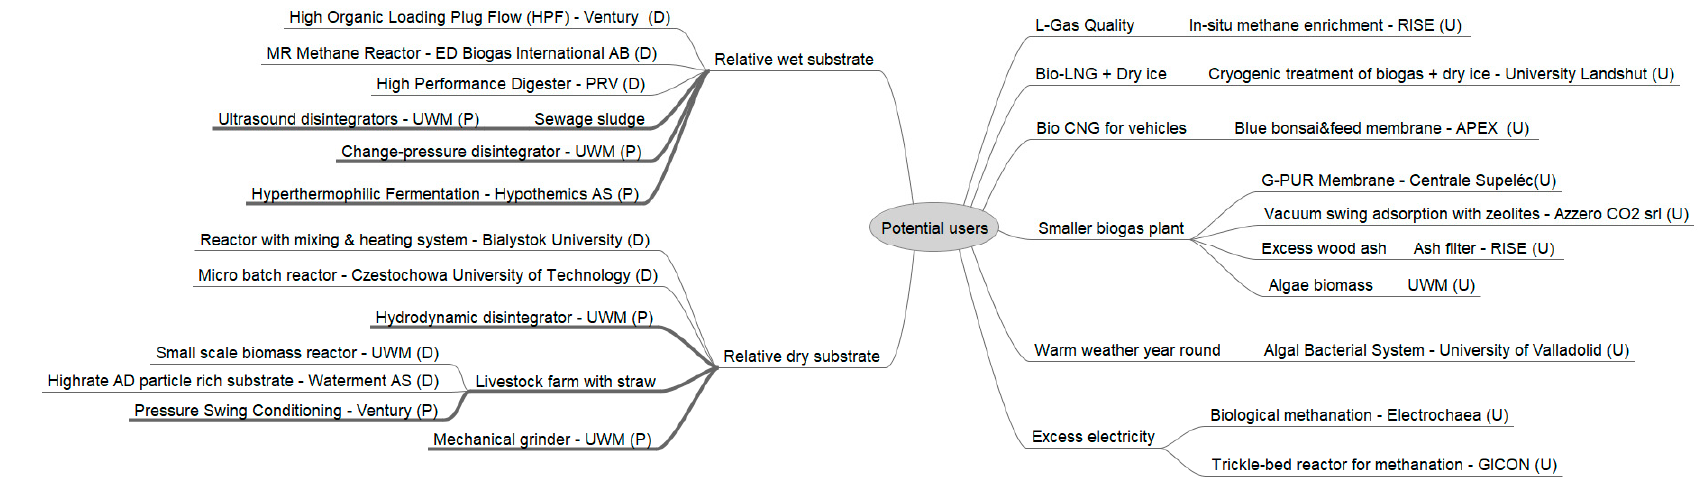
Figure A1. Graphical representation of the conditions relevant for each technology. Figure abbreviations: (P)–Pre-treatment, (D)–Digestion, (U)–Upgrading.